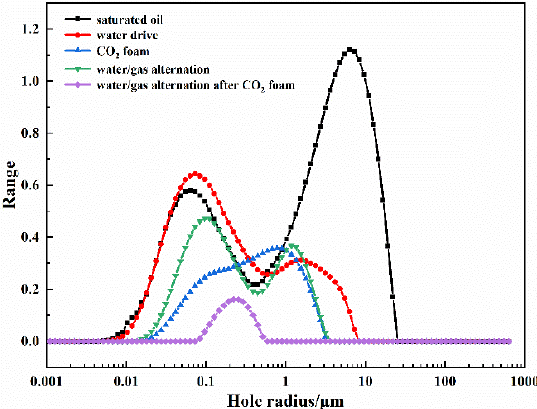
Figure 11. Pore throat radius distribution of different flow control systems in core No. 4.